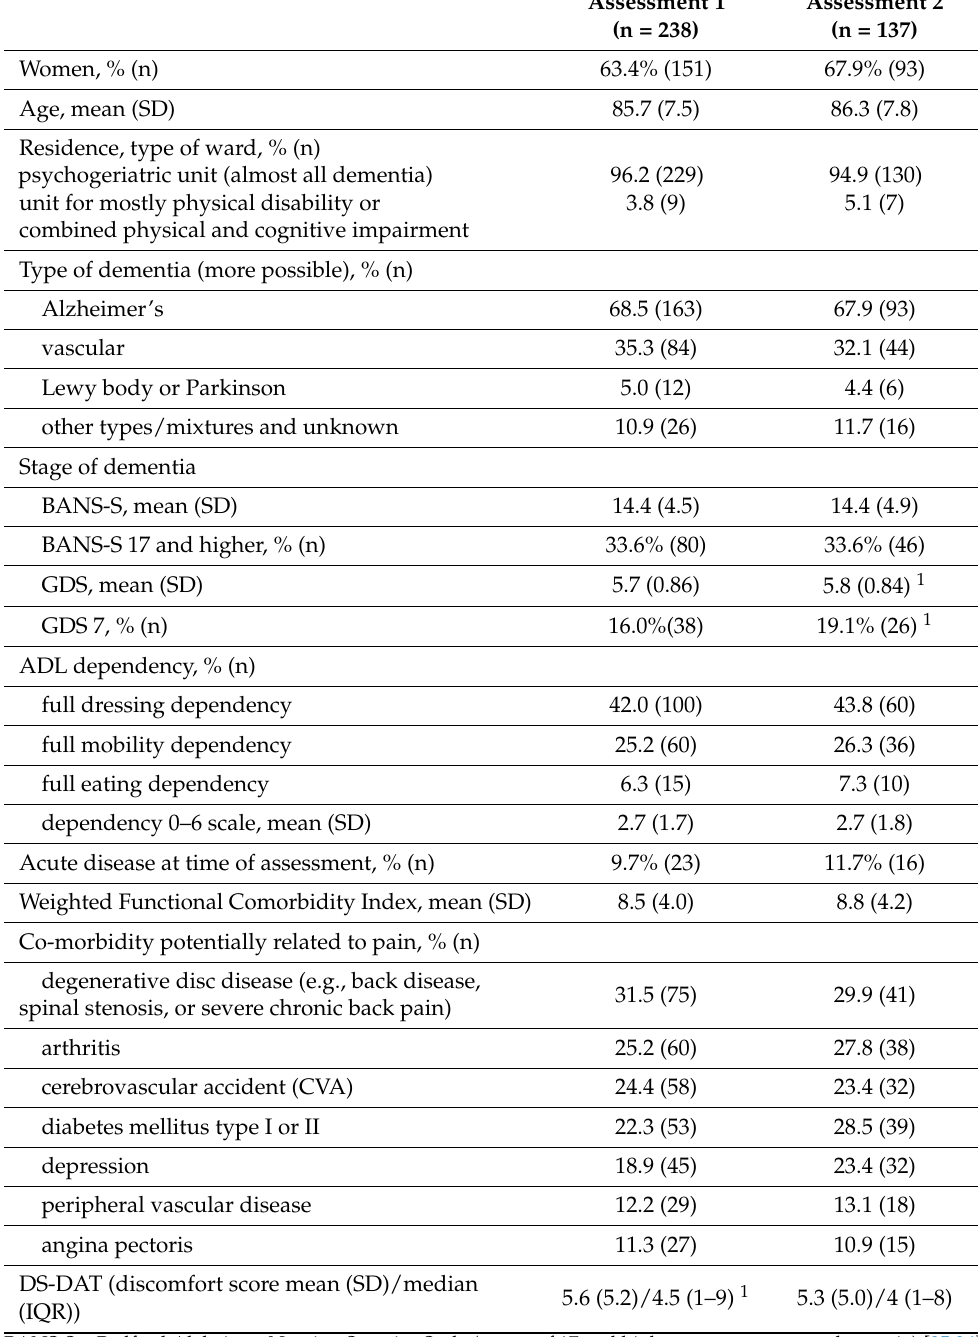
Table 1. Description of the sample of nursing home residents with dementia and